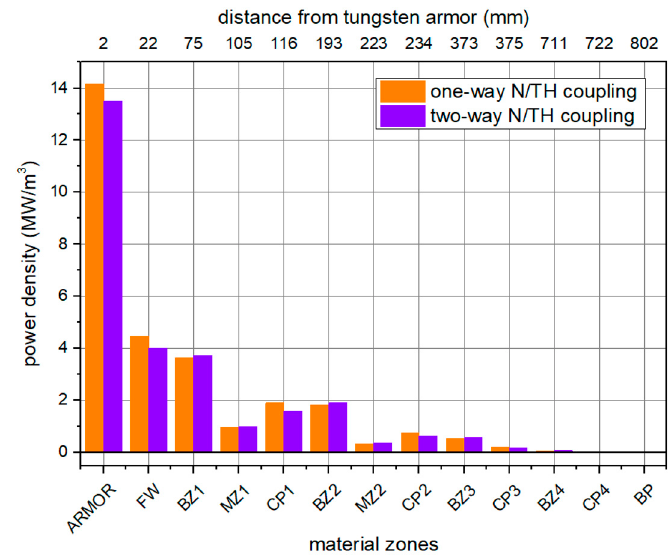
Figure 19. Radial power density distribution of the WCCB blanket.